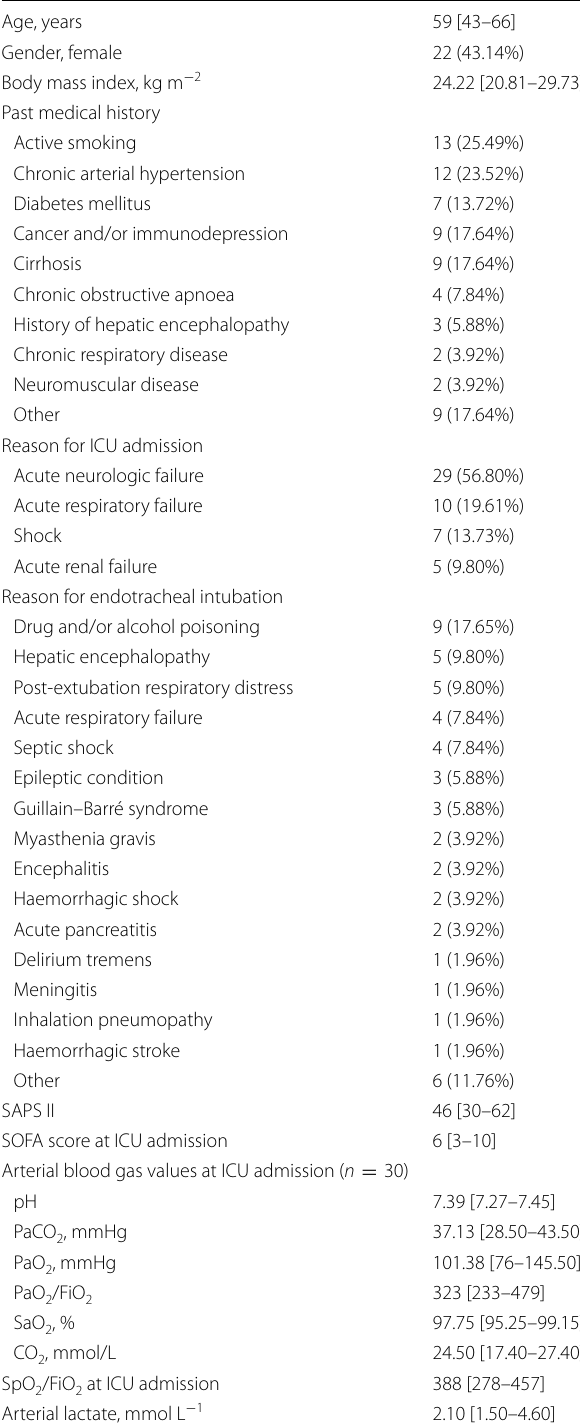
Table 1 Patients’ baseline